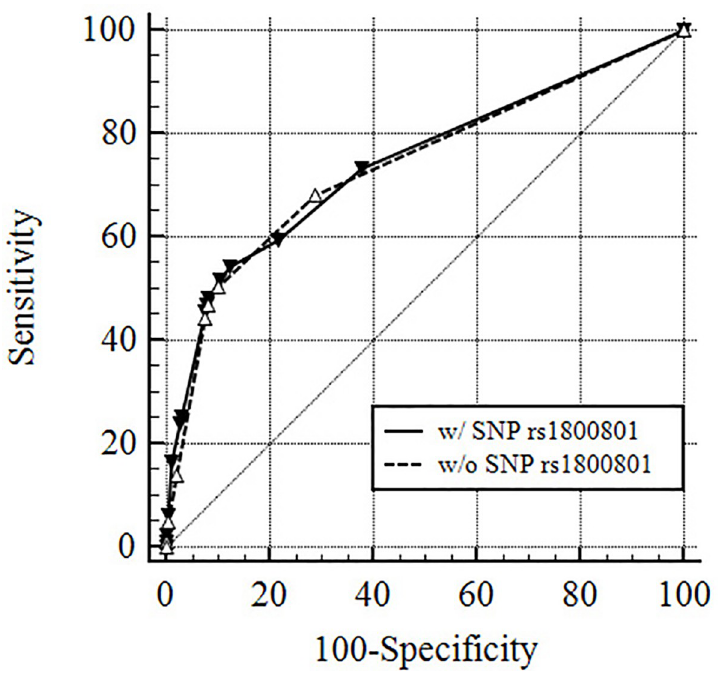
Fig 1. Receiver operating curves for prediction of recurrent stroke within the first year with and without MGP single nucleotide polymorphism rs1800801.